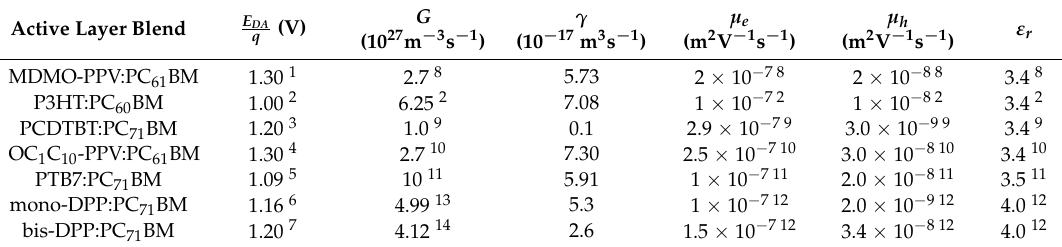
Table 1. List of input parameters required for calculating V OC from Equations (10), (15), and (18): − E D ) / q , generation rate of bound polaron pairs ( G ) and bimolecular E DA / q = ( E A LUMO HOMO recombination coefficient ( γ ) , electron (hole) mobility µ e ( µ h ) , and dielectric constant ε r of each donor-acceptor (D-A)